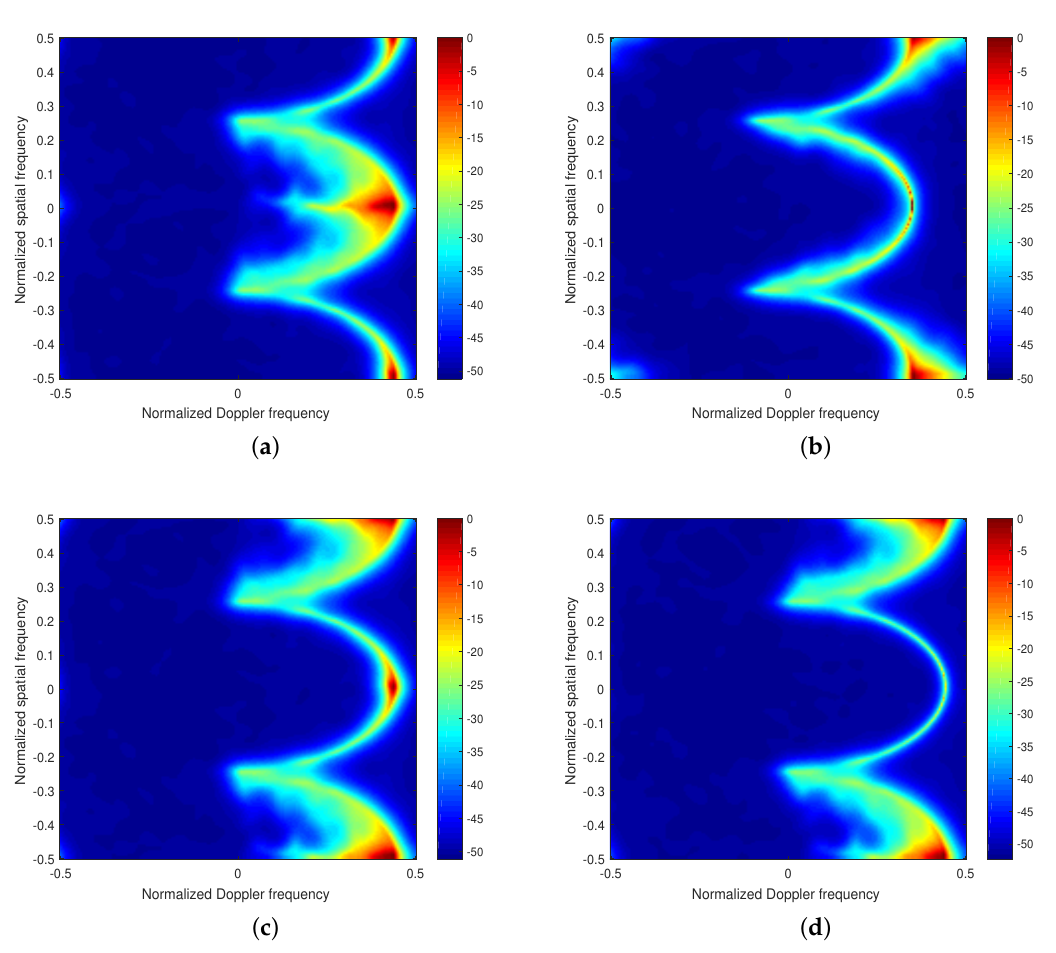
Figure 6. Clutter spectra ( a ) SRDC when α = 1 ( b ) SRDC and DW when α = 1 ( c ) SRDC when α = 2 ( d ) SRDC and DW when α =